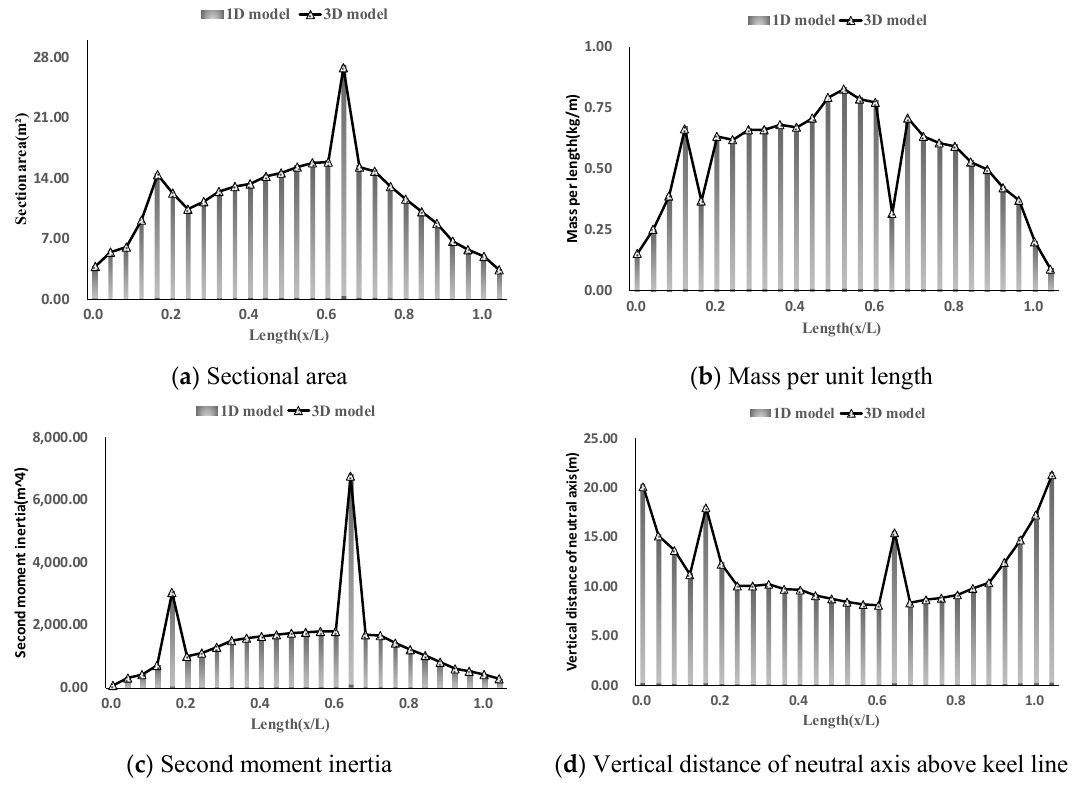
Figure 8. Ship property along the ship length. Table 2. Modal analysis.